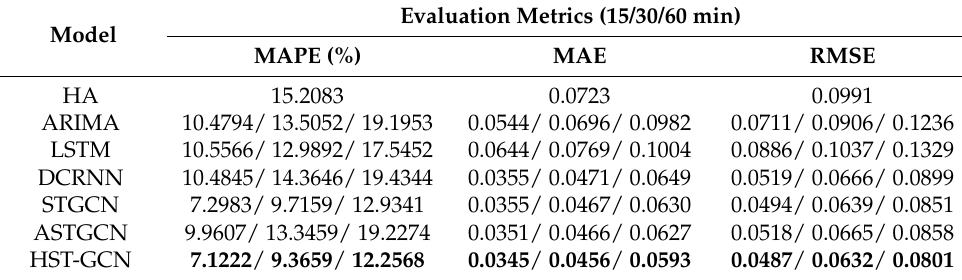
Table 2. Performance comparison of different models.